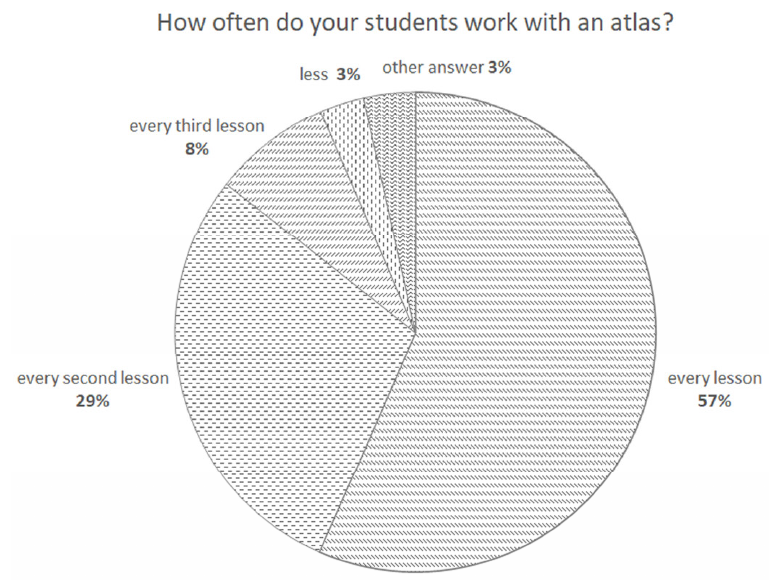
Figure 3. Summary of Q5—Frequency of atlas use.